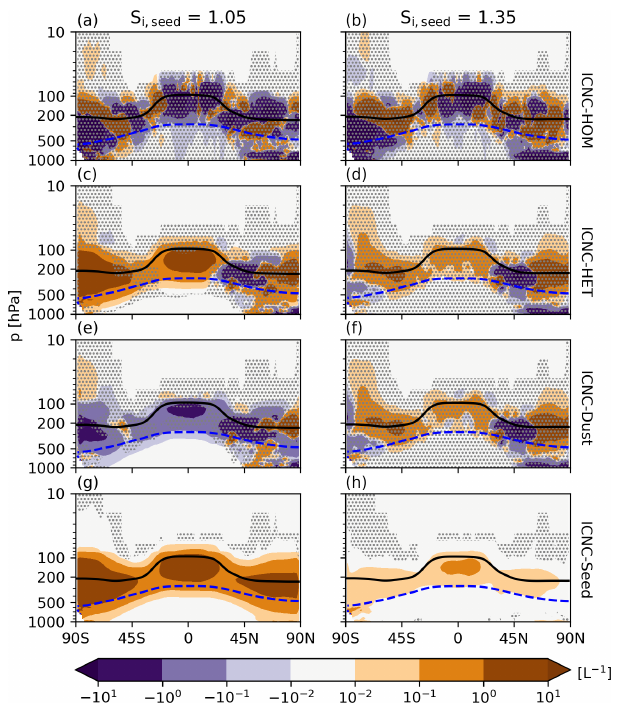
Figure 8. Five-year zonal mean ice number tracer anomalies in L − 1 between the Seed1 simulation and the unseeded reference case D19 for seeding particle critical saturation ratios 1.05 (left) and 1.35 (right). The anomalies include the in situ homogeneously nucleated ice number (a–b) , the in situ heterogeneous number (c–d) , the het- erogeneously nucleated ice number formed on mineral dust parti- cles (e–f) , and the heterogeneously nucleated ice number formed on seeding particles (g–h) . The black line is the 5-year mean zonal mean WMO-defined tropopause height on pressure levels, and the blue dashed line is the 238K temperature contour. The stippling in the difference plots shows insignificant data points at the 95% con- fidence level according to the independent t test controlled by the false discovery rate